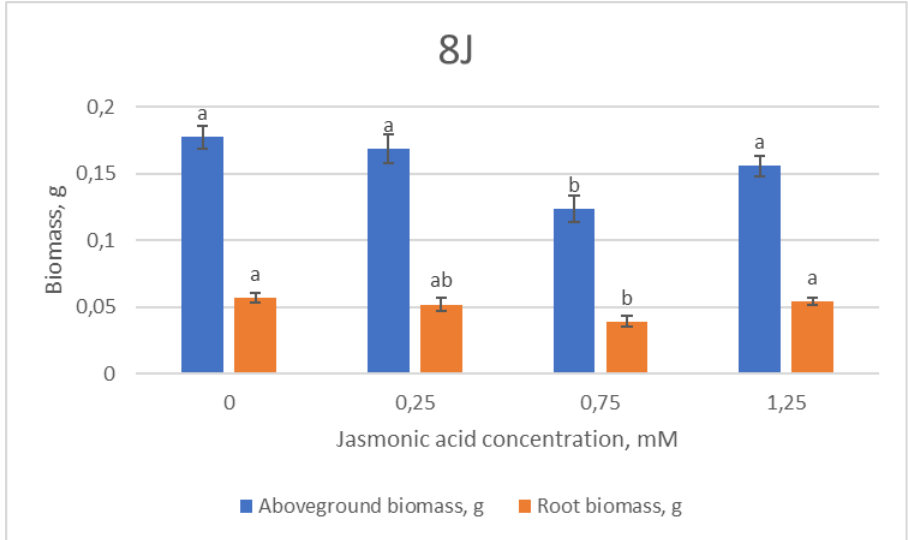
Figure 1. Means (g) ± SE of above-ground and root biomass of Scots pine half-sib family 8J, measured 6 weeks after sowing. Data significance was calculated using the Kruskal–Wallis H test for ranks and post hoc Dunn’s test for pairs ( p < 0.05). Different letters next to different colors indicate significant differences between the groups, sprayed with different concentrations of jasmonic acid.